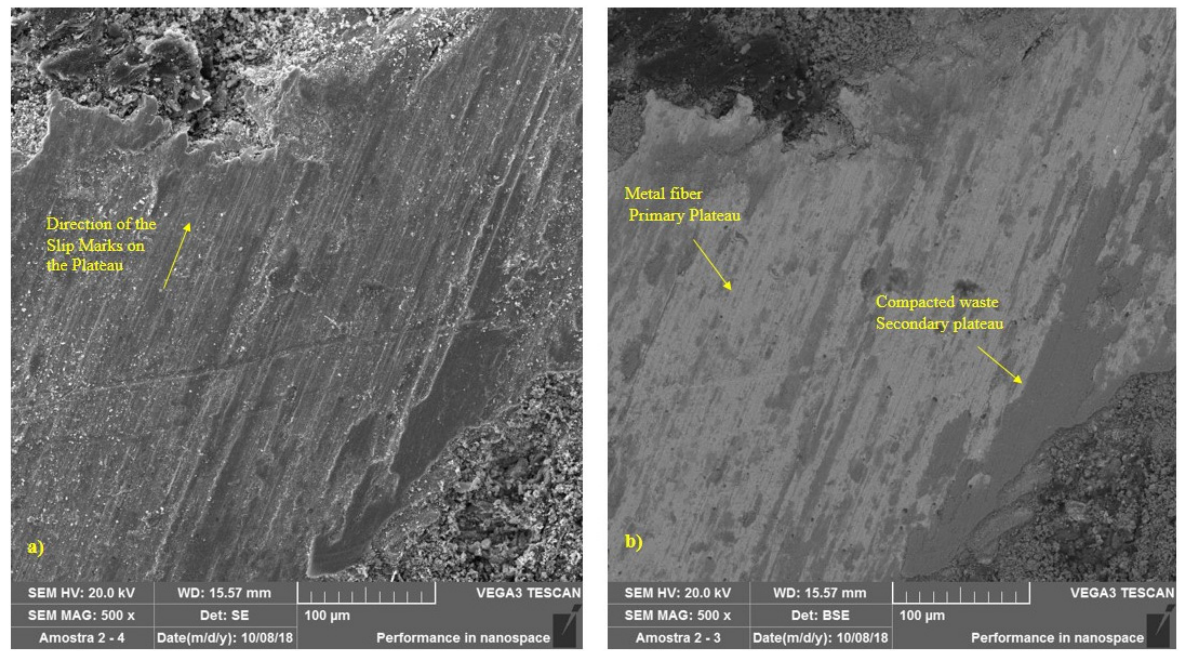
Figure 8. SEM images—500×—for pads under simulated downhill; ( a ) SE; ( b ) BSE.